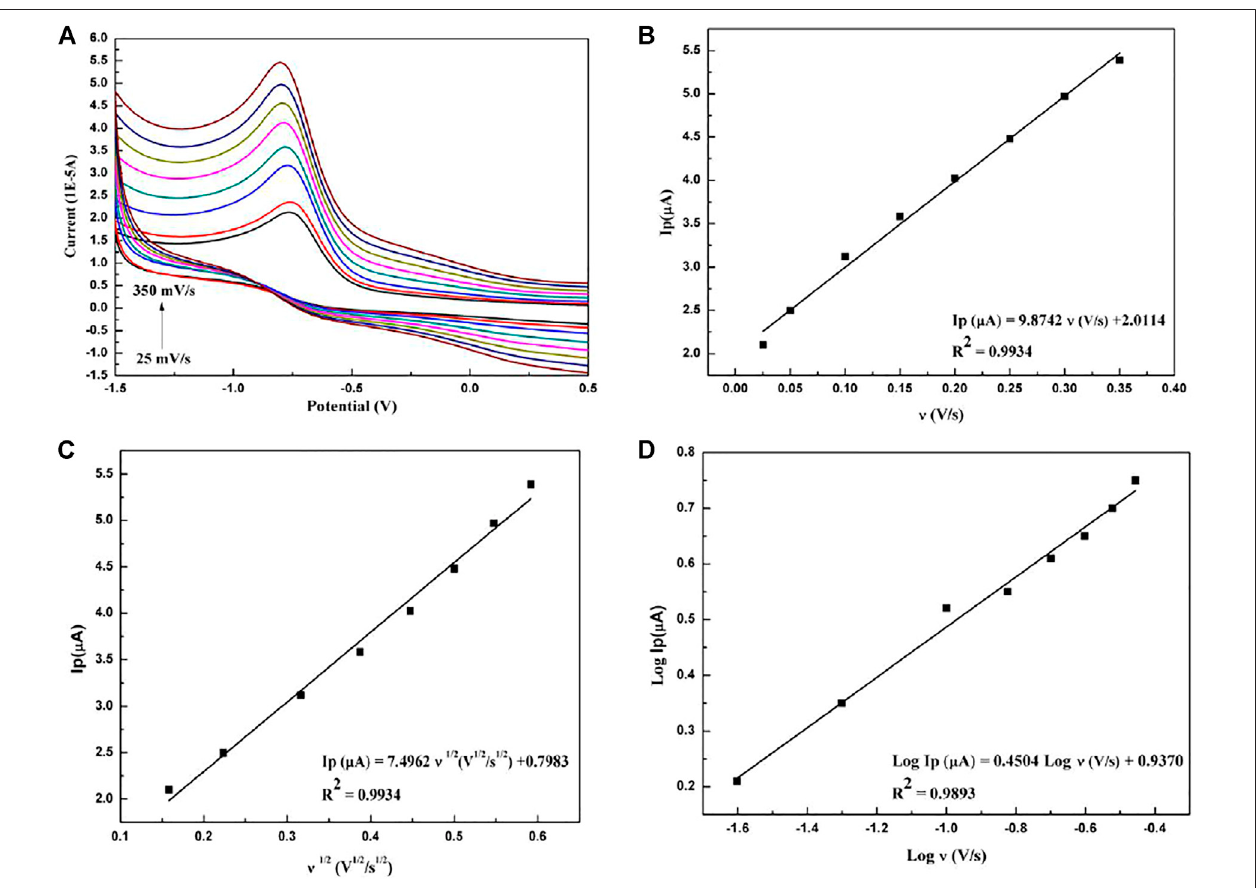
FIGURE 4 | (A) Cyclic voltammograms of paclitaxel (1 × 10 − 5 mol/L) with different scan rates: 0.025, 0.05, 0.10, 0.15, 0.20, 0.25, 0.30, and 0.35 V/s. (B) Dependence of peak current on scan rate. (C) Dependence of peak current on the square root of scan rate. (D) The linear relationship between the logarithm of peak current and logarithm of scan